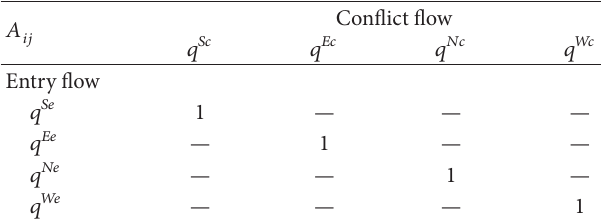
Table 1: Conflict matrix of an A-type